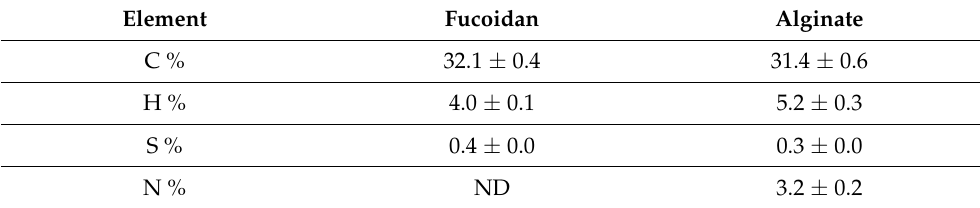
Table 2. Elemental analysis (CHNS) of fucoidan and alginate extracts isolated from Fucus spiralis biomass.